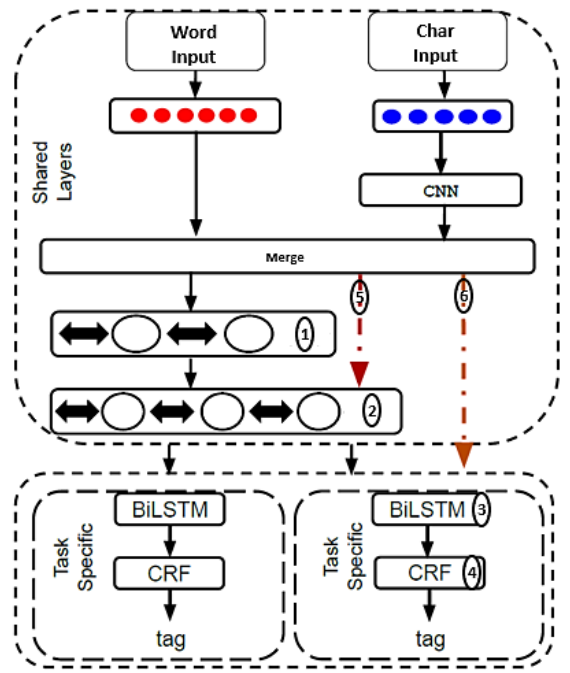
Figure 4. Proposed MTM-CW Model where dashed arrows show skip connections. Circles represent